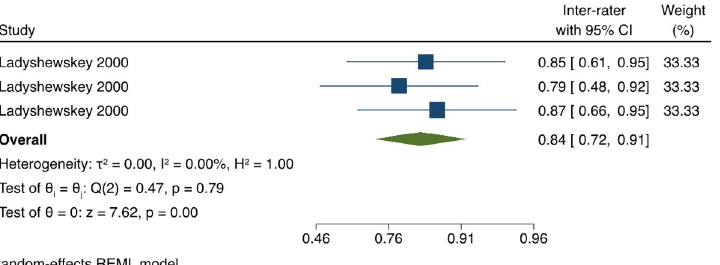
Fig 7. Meta-analysis of kappa coefficient for inter-rater reliability between standardised patients on OSCE’s in physical therapy students. Forest plot presenting the meta-analyzed estimate on kappa coefficient. Each square presents the results of an individual study with the size of the square being proportional to the weights used in the meta-analysis and the horizontal lines indicating the 95% confidence intervals. The solid diamond indicates the overall summary